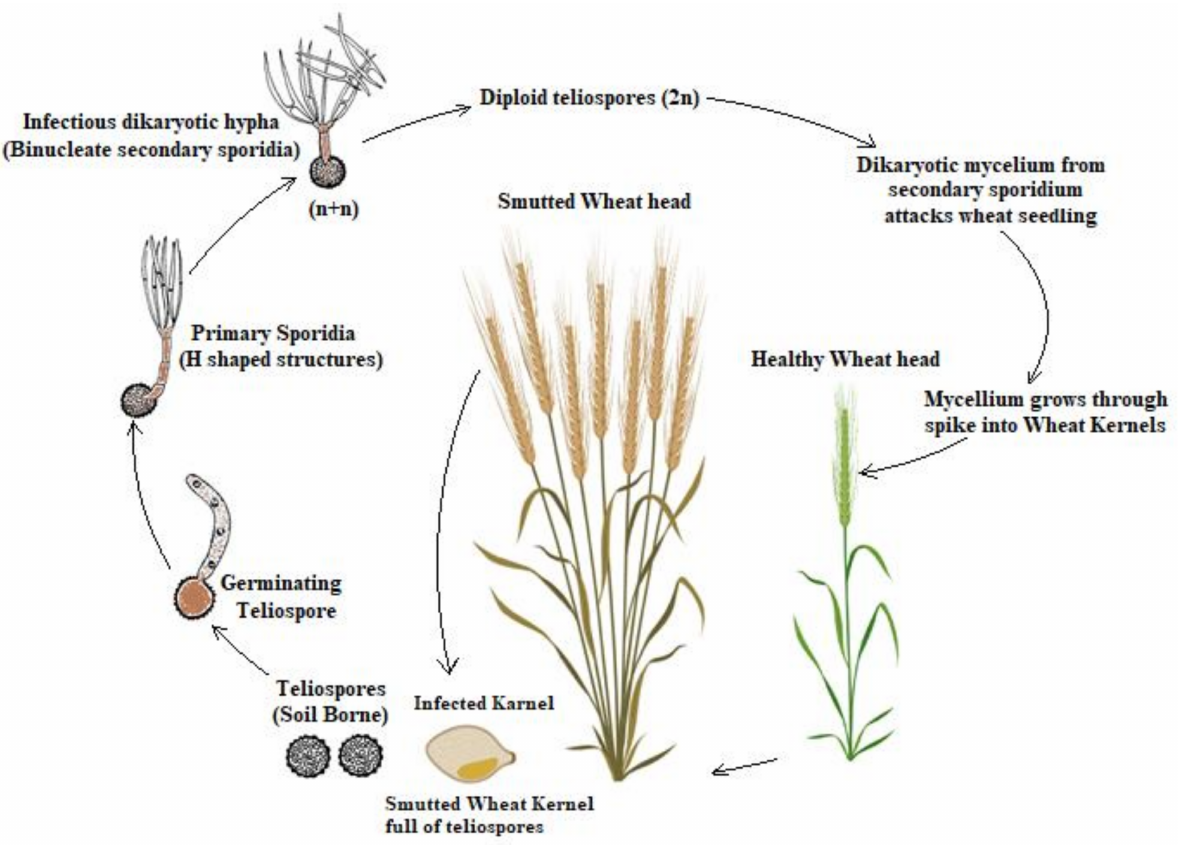
Figure 1. Disease cycle of the causal pathogen, Tilletia indica